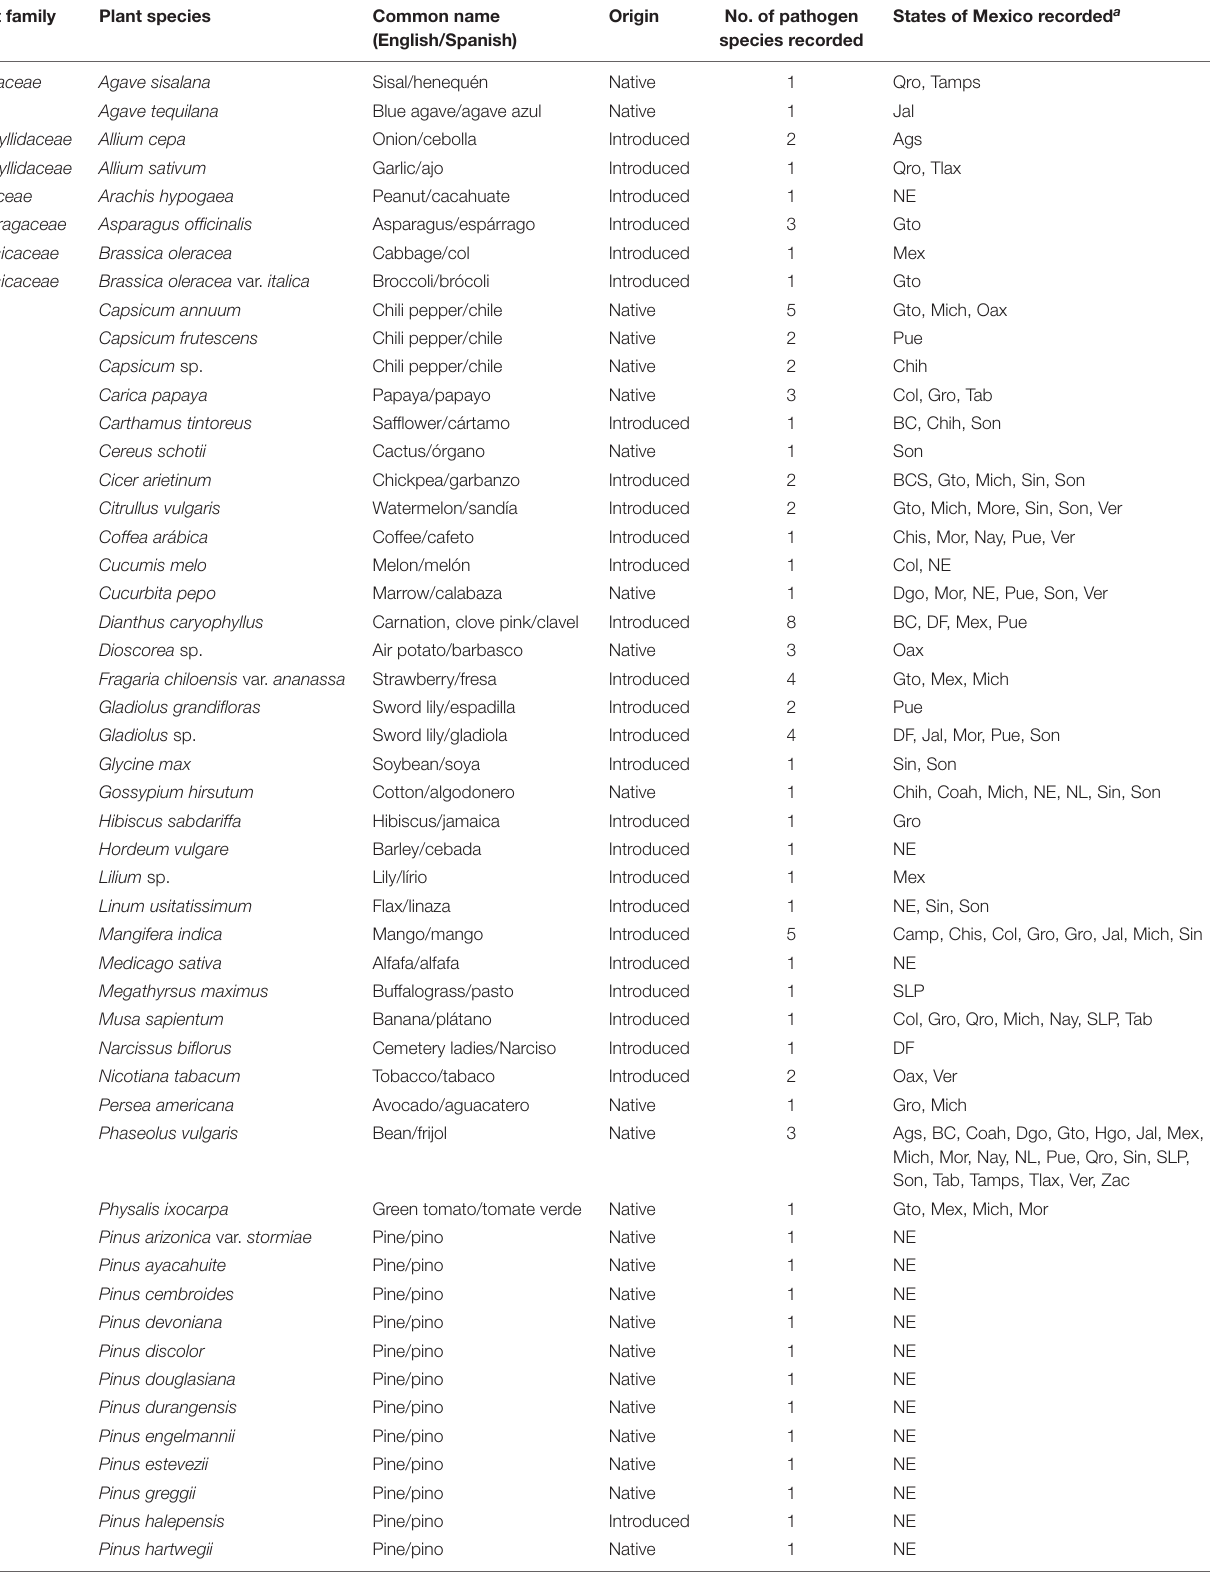
TABLE 1 | List of different native and introduced cultivated plant species attacked by species of the genus Fusarium in Mexico. Plant family Plant